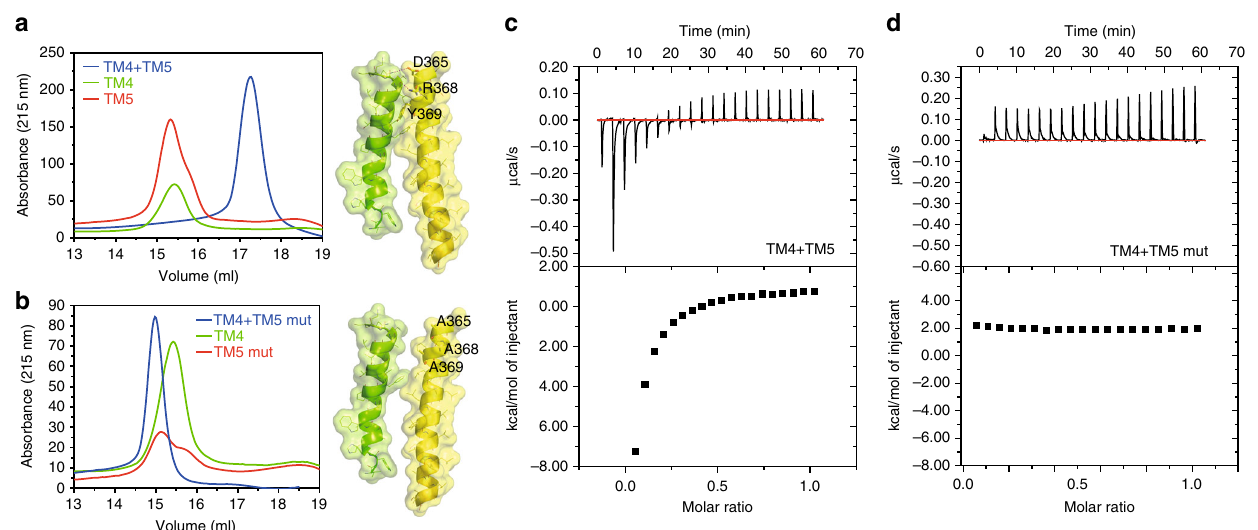
Fig. 3 Mutation of TM5 decreases af fi nity between the TM4/5 peptides in DDM solution. a , b Size-exclusion chromatography experiments were performed in triple distilled water (TDW) and 0.01 % DDM. Final concentration of 500 µ M from each peptide in TDW + 0.01 % DDM was injected into the size-exclusion column and their absorbance was detected as explained in the methods section. a Elution pro fi les of synthetic peptides TM4 and TM5 alone and in combination. b Elution pro fi les of TM4 and mutated TM5 (TM5 mut) peptides are shown. Helical peptide models (TM4 — yellow ; TM5 — green ) visualize the expected van der Waals interaction between TM4/5 and the lack thereof in the mutated peptide derived from the FZD 6 model presented in Fig. 2. c Isothermal titration calorimetry (ITC) experiments were performed in 0.5% DDM at 20 °C. ITC curves for the titration of 820 µ M FZD 6 -TM5 peptide into 165 µ M FZD 6 -TM4 are shown. d Titration of 820 µ M FZD 6 -TM5 mut peptide into 165 µ M FZD 6 -TM4 is shown. Fitting the binding curve to one set of sites resulted in an af fi nity (dissociation constant; K D ) in the micromolar range. The precise K D value could not be determined due to high background, which is likely to be caused by the dimerization of the FZD 6 -derived peptides. Control experiments with TM4, TM5, and TM5 mut peptides alone are shown in Supplementary Fig. 5e –